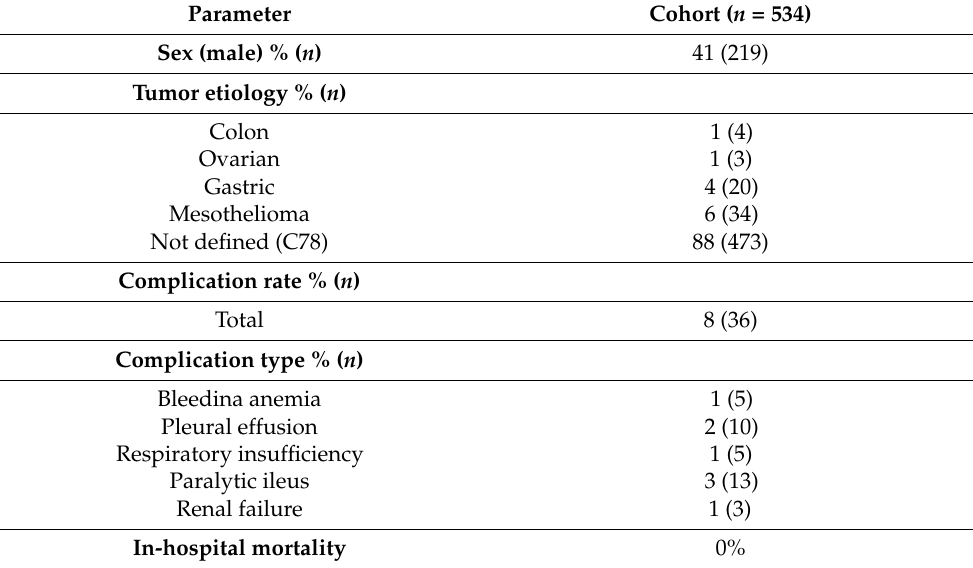
Table 1. Patient data of the